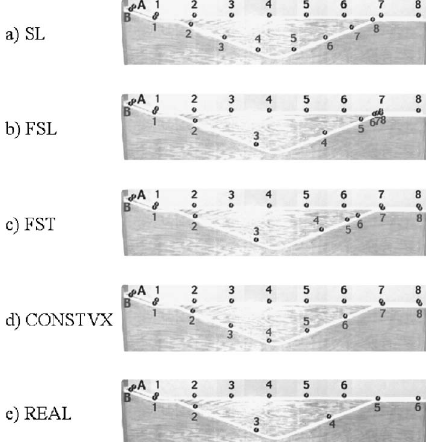
FIG. 1. Strobe diagrams indicating positions of balls on tracks A and B in every ninth frame of the two-ball animations (cid:1) QuickTime movies (cid:2) . The motion of ball B varies across animations after it enters the valley. (cid:1) a (cid:2) Slow-lose (cid:1) SL (cid:2) : ball B lags behind ball A. (cid:1) b (cid:2) Fast-slow-lose (cid:1) FSL (cid:2) : ball B experiences an exaggerated decelera- tion on the final slope. (cid:1) c (cid:2) Fast-slow-tie (cid:1) FST (cid:2) : while rolling uphill, ball B slows down and then speeds up. (cid:1) d (cid:2) Constant-Vx (cid:1) CON- STVX (cid:2) : the balls are always tied. (cid:1) e (cid:2) Realistic (cid:1) REAL (cid:2) : realistic motion for ball